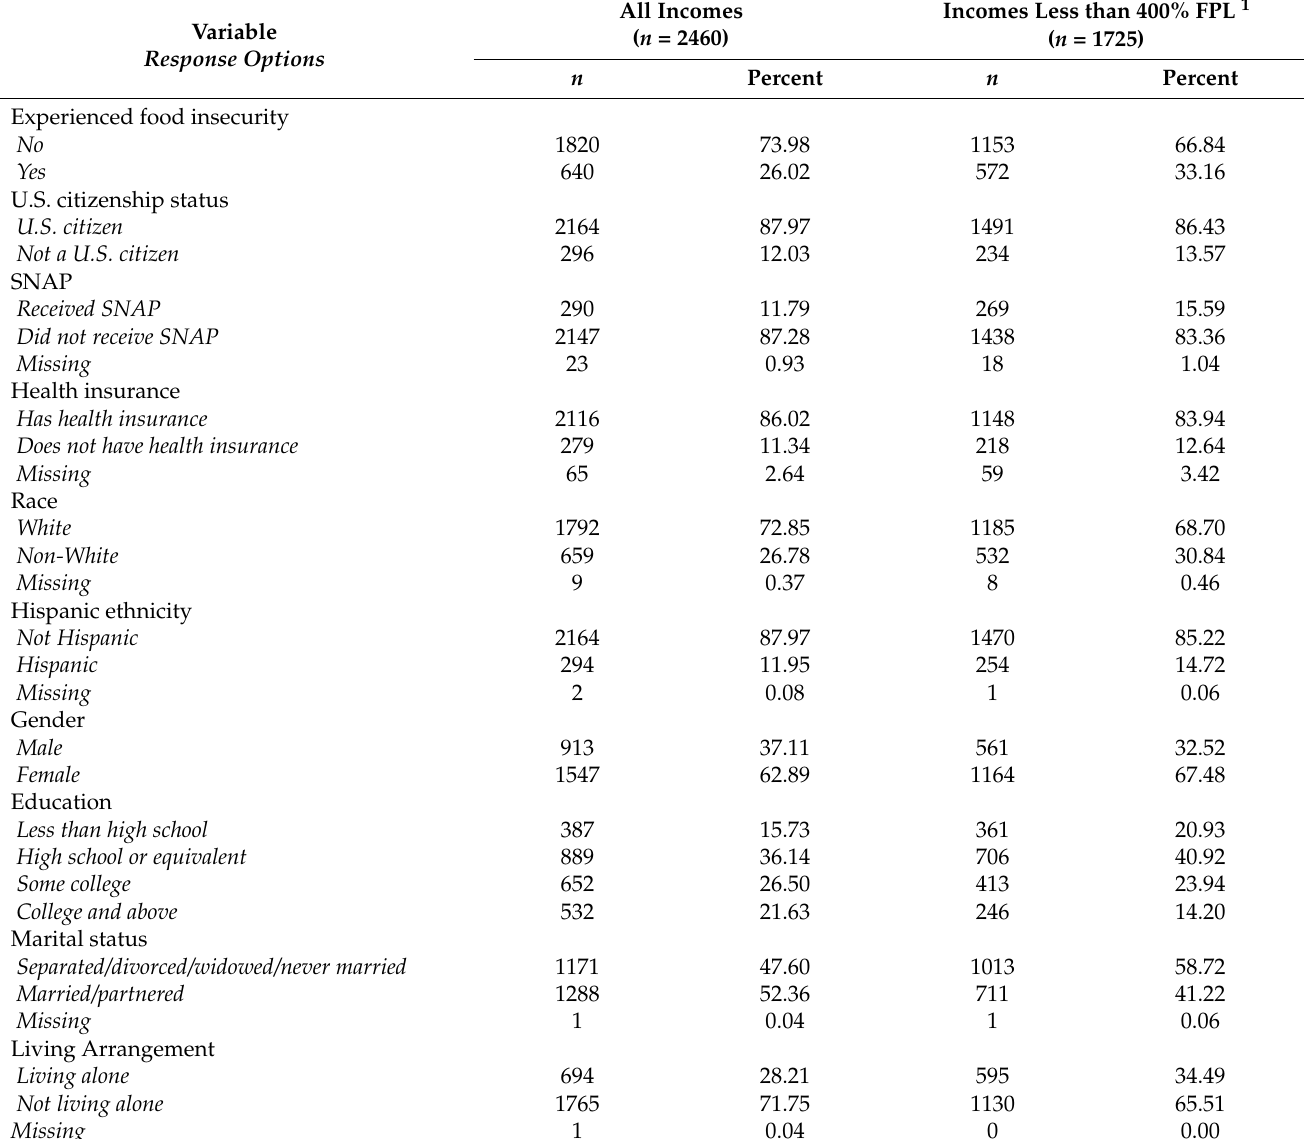
Table 1. Descriptive statistics for categorical outcome, associated, and control variables from the Health and Retirement Study used in the regression analysis for individuals with any income ( n = 2460) and individuals with incomes less than 400% FPL ( n =